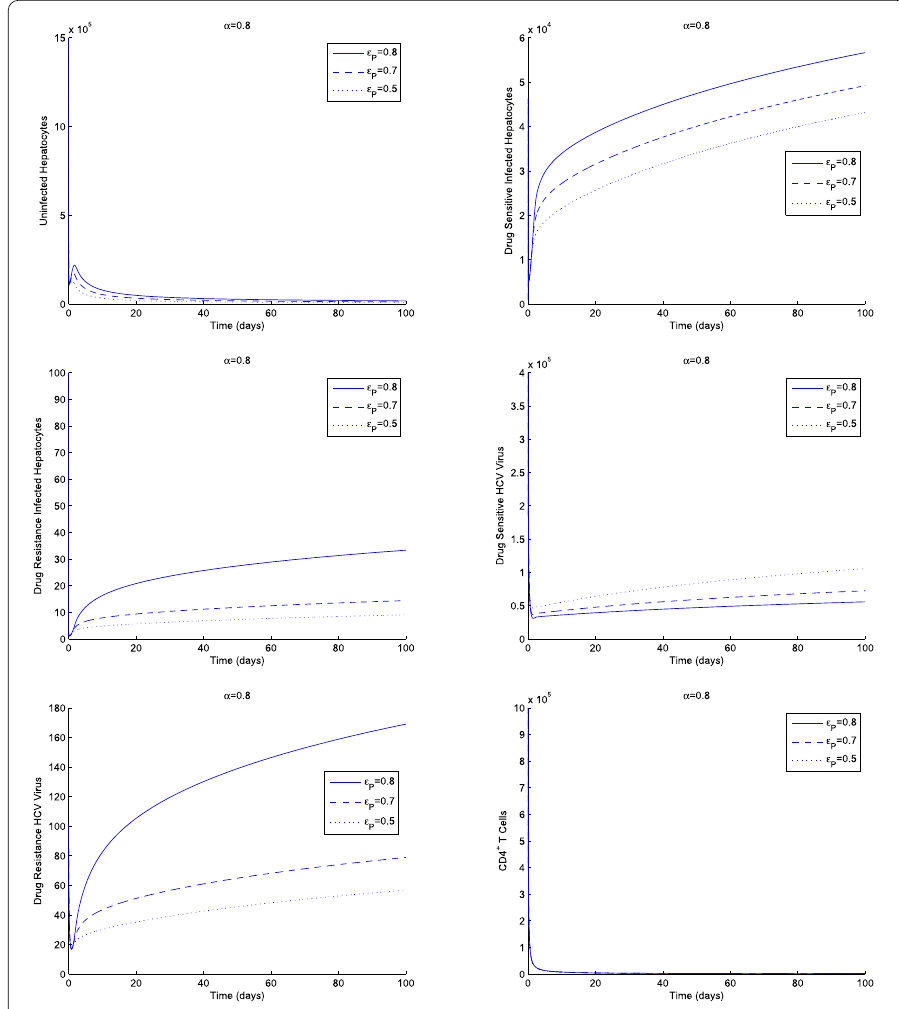
Figure 7 Dynamics of the variables of system (1) for different values of (cid:3) P , the protease inhibitor drug efficacy, and α = 0.8. Parameter values are in Table 1 and initial conditions are given in the text.